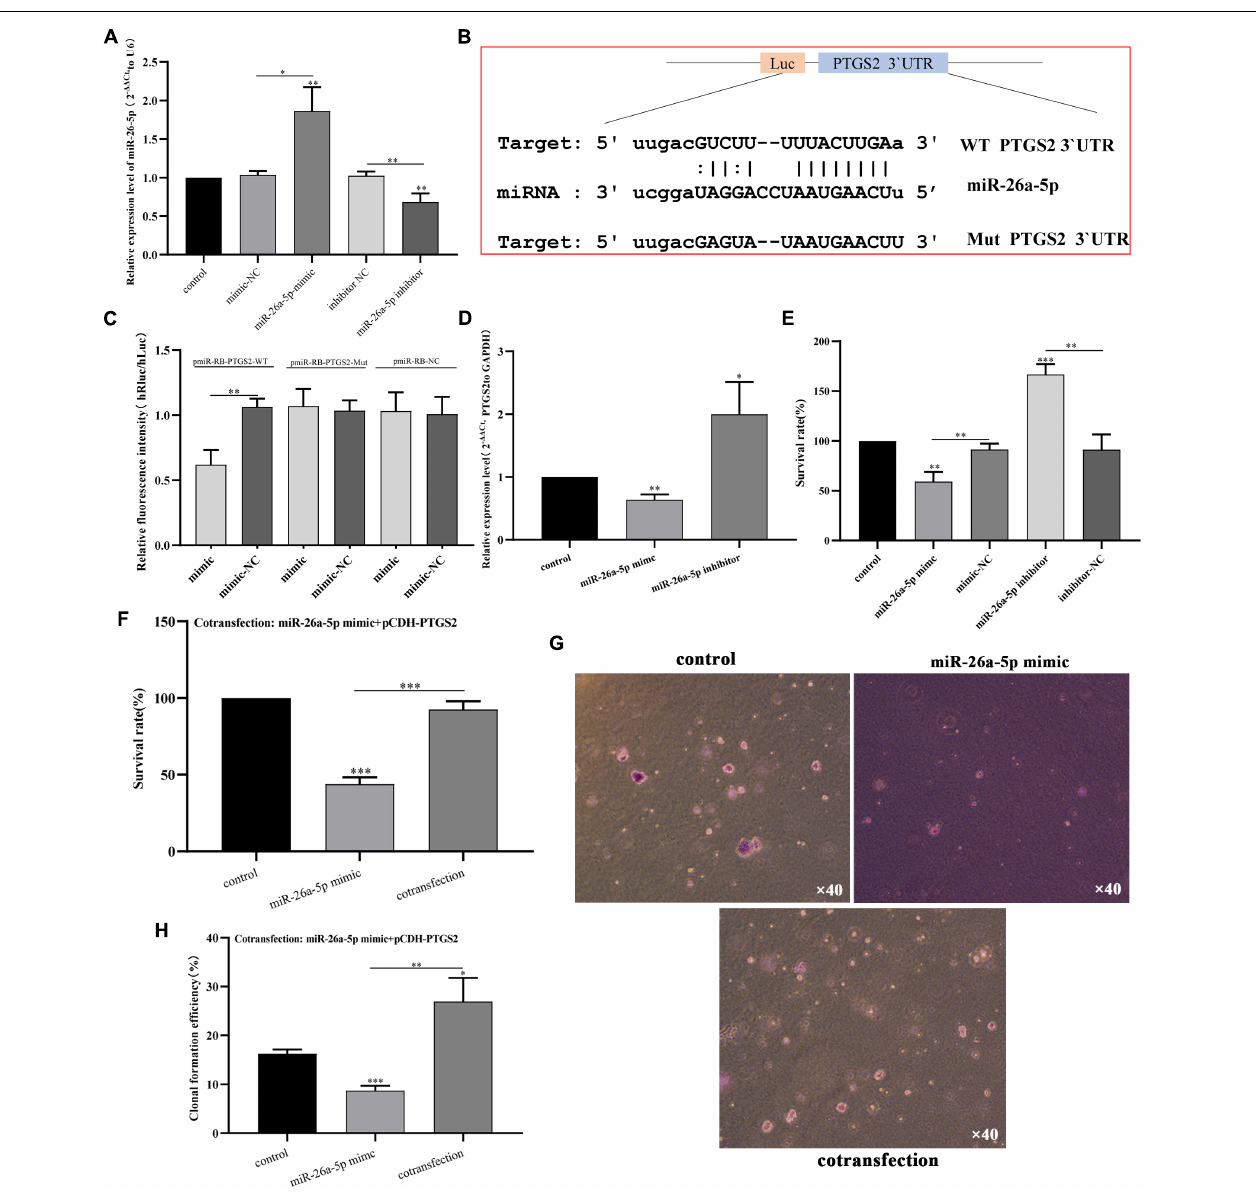
FIGURE 8 | (A) The transfection efficiency of miR-26a-5p (miR-26a-5p mimic and miR-26a-5p inhibitor) was detected by qPCR. The expression level of U6 was used as an internal reference for miR-26a-5p. The data are shown as the mean ± standard deviation. (B) Binding site sequences of miR-26a-5p and PTGS2 3 ’UTR. (C) Luciferase activity of WT or Mut PTGS2 after co-transfection of miR-26a-5p mimic and WT or Mut PTGS2 dual-fluorescent vector into SH-SY5Y cells. (D) The effects of miR-26a-5p mimic and mir-26a-5p inhibitor on the expression of PTGS in AD model cells (A β 25 − 35 -treated SH-SY5Y cells) were detected by qPCR. (E) The effects of miR-26a-5p mimic and miR-26a-5p inhibitor on the vitality of AD model cells (A β 25 − 35 -treated SH-SY5Y cells) measured using the CCK-8 assay. (F) The effects of cotransfection (pCDH-PTGS2 and miR-26a-5p mimic) on the vitality of AD model cells (A β 25 − 35 -treated SH-SY5Y cells) measured using the CCK-8 assay. (G,H) The effects of cotransfection (pCDH-PTGS2 and miR-26a-5p mimic) on the proliferation of AD model cells (A β 25 − 35 -treated SH-SY5Y cells) measured using the soft agar assay. Scales: 10 × 40. The data are shown as the mean ± standard deviation. The horizontal line indicates the comparison between groups at both ends, and the non-horizontal line indicates the comparison with the control group. AD, Alzheimer’s disease. ∗∗∗ p < 0.001; ∗∗ p < 0.01; ∗ p <